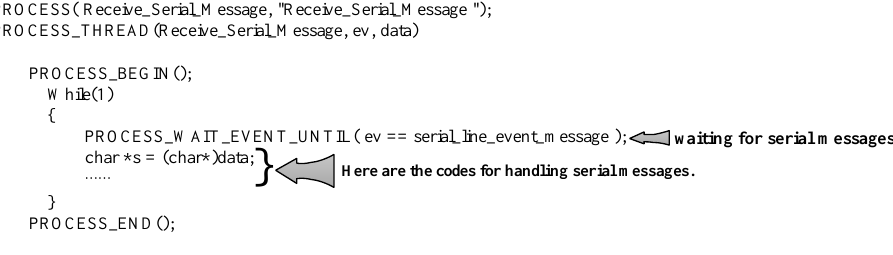
waiting for serial messages